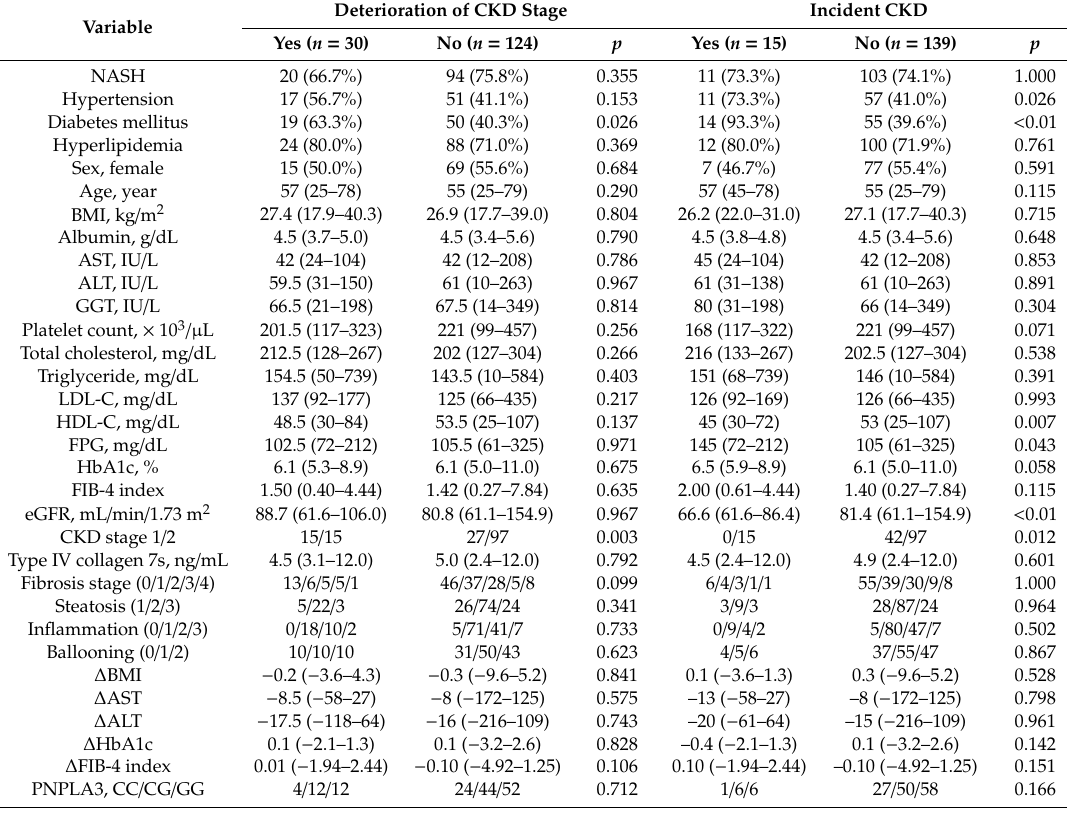
Table 3. Demographic profiles and laboratory and histological data of patients, grouped according to the incidence of chronic kidney disease during the follow-up period.